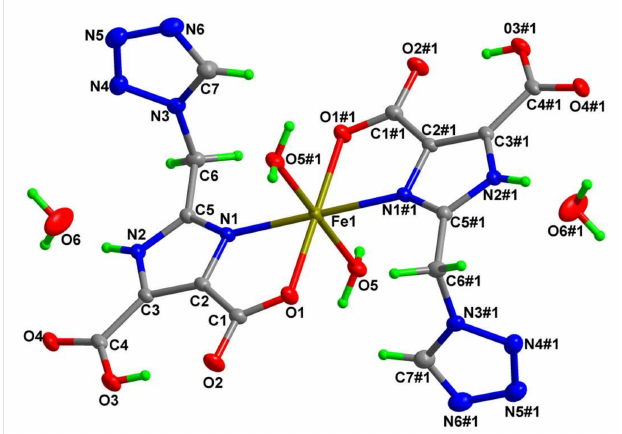
Figure 1. Coordination environment of the Fe(II) ion in complex 2 with the atom numbering scheme, displacement ellipsoids are drawn at the 30% probability